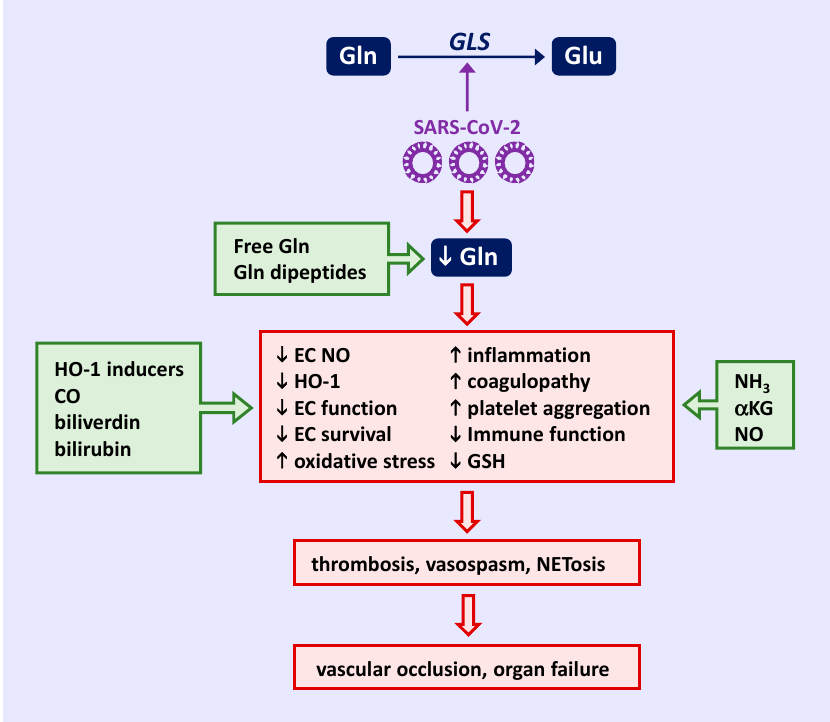
Figure 2. Targeting Gln in COVID-19-mediated immune and endothelial dysfunction. SARS-CoV-2 lowers circulating levels of Gln by increasing GLS activity. The resulting decline in Gln compromises EC function and NO production by limiting cellular Arg levels. The loss of Gln also stimulates vascular inflammation, platelet aggregation, coagulopathy, and reduces the viability of ECs by restricting NO synthesis and the induction of HO-1. In addition, Gln deficiency causes a broad dysfunction of the immune system that worsens the severity of infection. The consumption of Gln in COVID-19 will also increase oxidative stress by reducing the synthesis of GSH and expression of HO-1. Collectively, these actions will promote vasospasm, thrombosis, and NETosis, resulting in vascular occlusion and multi-organ failure. Several strategies may be employed to target glutamine in COVID-19. Dietary supplementation with free or dipeptide forms of Gln provides a straightforward approach to restore circulating levels of Gln in SARS-CoV-2-infected patients. Alternatively, the direct administration of Gln metabolites (NH 3 or α KG) or downstream effectors of Gln (inhaled NO, NO donors, HO-1 inducers, CO donors, biliverdin, or bilirubin) provides a more selective avenue in correcting disturbances of Gln metabolism in patients with COVID-19. Downward pointing arrows indicate a decrease while upward pointing arrows indicate an increase. Gln, glutamine; Glu, glutamate; COVID-19, coronavirus disease 2019; SARS-CoV-2, severe acute respiratory syndrome coronavirus 2; GLS, glutaminase; EC, endothelial cell; NO, nitric oxide; Arg, arginine; HO-1, heme oxygenase-1; GSH, glutathione; NETosis; the release of neutrophil extracellular traps; NH 3 , ammonia; α KG, alpha-ketoglutarate; CO, carbon